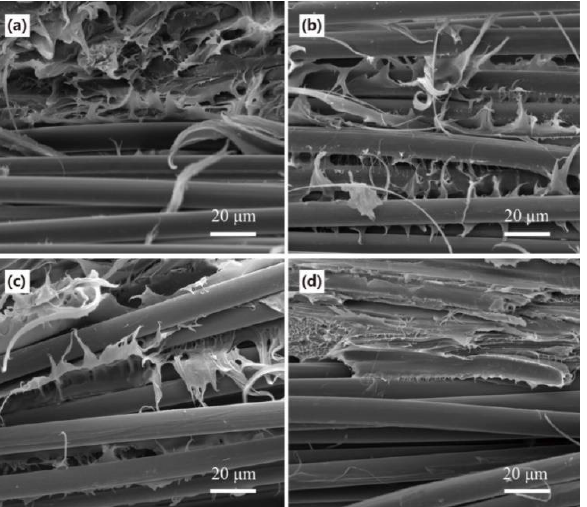
Figure 8. Fracture morphology of the CAF reinforced WPCs: ( a ) virgin, ( b ) dopamine-treated, ( c ) vinyl triethoxysilane-treated, and ( d ) dopamine and vinyl triethoxysilane-treated.